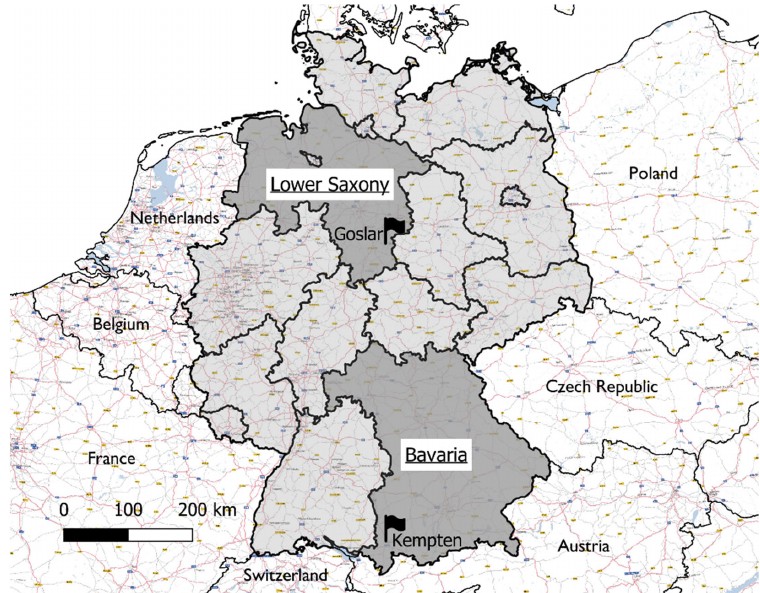
Figure 1. The cities of Goslar and Kempten in Germany. Kempten is located in the federal state of Bavaria and Goslar in Lower Saxony. Bavaria and Goslar in Lower